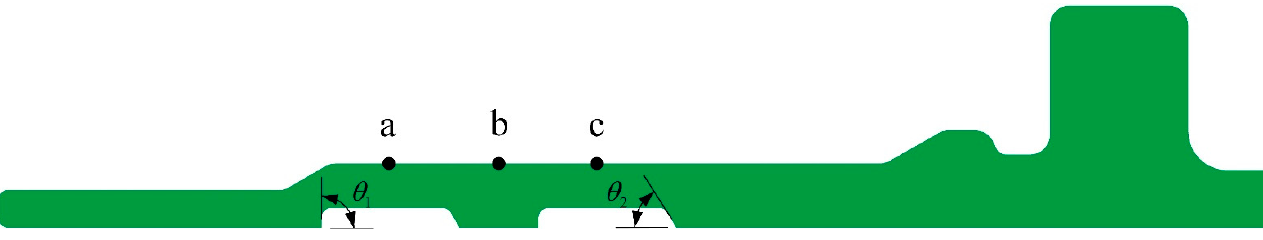
Figure 13. The structure of the fittings body.